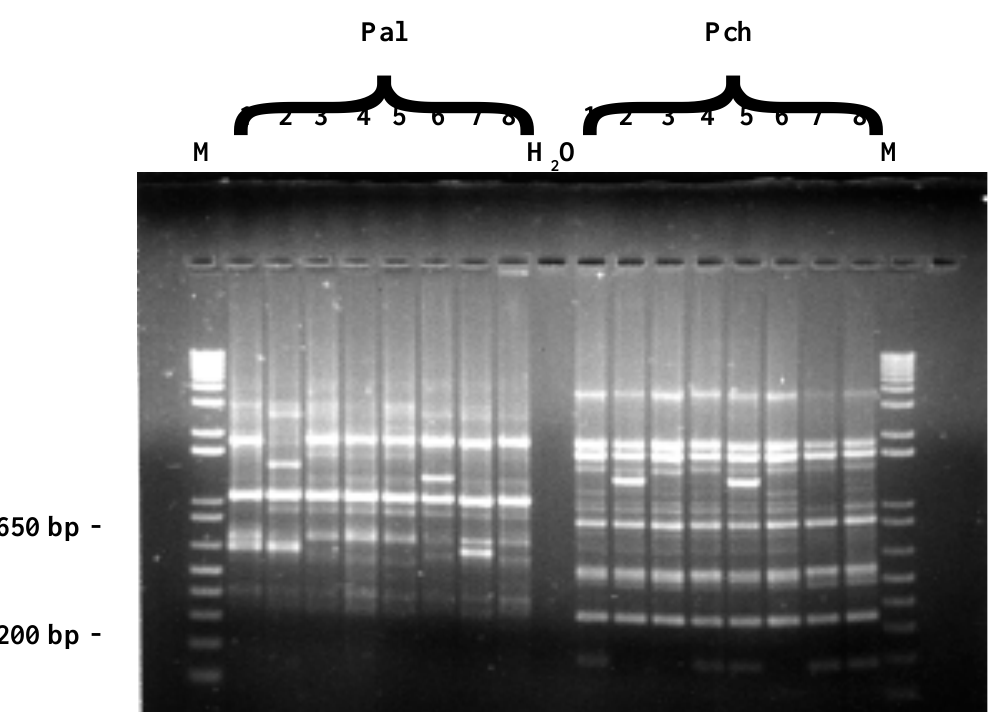
respectively.Fig. 1. Gel electrophoresis of the PCR products obtained with primer OP-B12 with Pal and Pch isolates. Lanes M, 1Kb Plus DNA Ladder (Gibco-BRL, Life Technologies); lane H